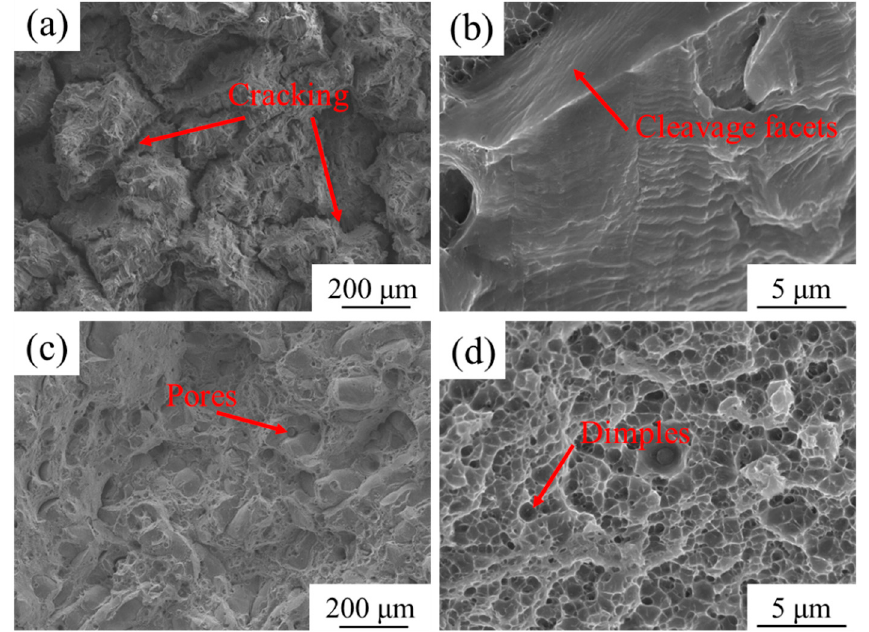
Figure 14. SEM morphology of tensile fracture surface of the as-printed Al-6.2Zn-2Mg-xSc-xZr alloy, ( a ) sample 3, ( b ) sample 3, ( c ) sample 4, ( d ) sample 4. Table 2. Mechanical properties of the as-printed Al-6.2Zn-2Mg-xSc-xZr alloys. No. Ultimate Tensile Strength/MPa Yield Strength/MPa Elongation/% Sample 3 250.0 ± 5.3 179.0 ± 1.0 8.5 ± 1.8 Sample 4 327.3 ± 7.1 254.7 ± 5.5 19.2 ± 0.3